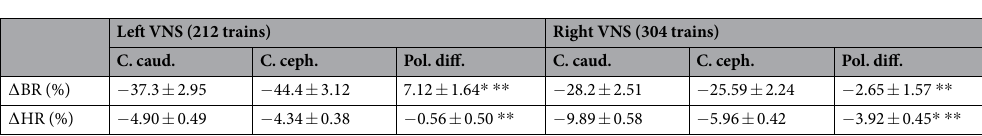
Table 3. Similar to Table 1, but this time for trains of stimuli with left VNS, and right